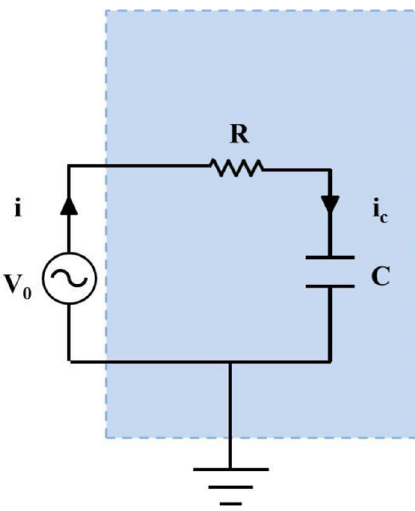
Fig. 2. Representation of a monolayer wall as an electrical